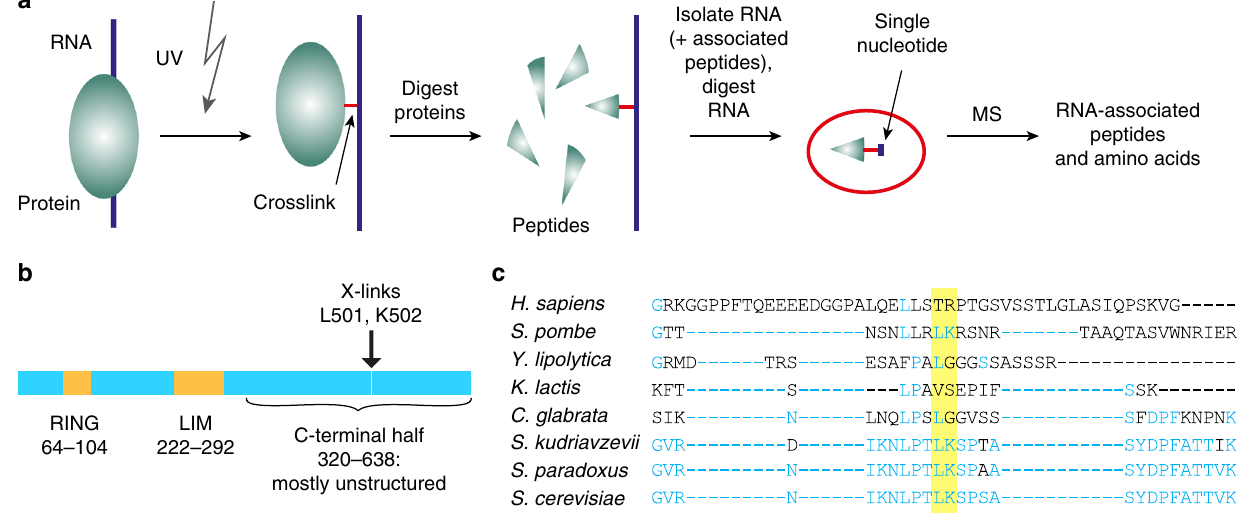
Fig. 1 iRAP and iRAP-identi fi ed Hel2 crosslink sites, sequence and structure elements and conservation. a Schematic representation of the iRAP procedure. b Positioning of sequence and structural elements as well as crosslinked amino acids revealed by iRAP within the Hel2 primary structure. See Supplementary Fig. 3 for a structure prediction of Hel2. c Multiple sequence alignment of crosslink-proximal amino acids of Hel2 from S. cerevisiae , S. paradoxus , S. kudriavzevii , C. glabrata , K. lactis , Y. lipolytica and S. pombe with H. sapiens ZNF598. The two crosslinked amino acids and corresponding amino acids in homologues are highlighted in yellow. Conserved amino acids are shown in blue (conservation w.r.t. S. cerevisiae